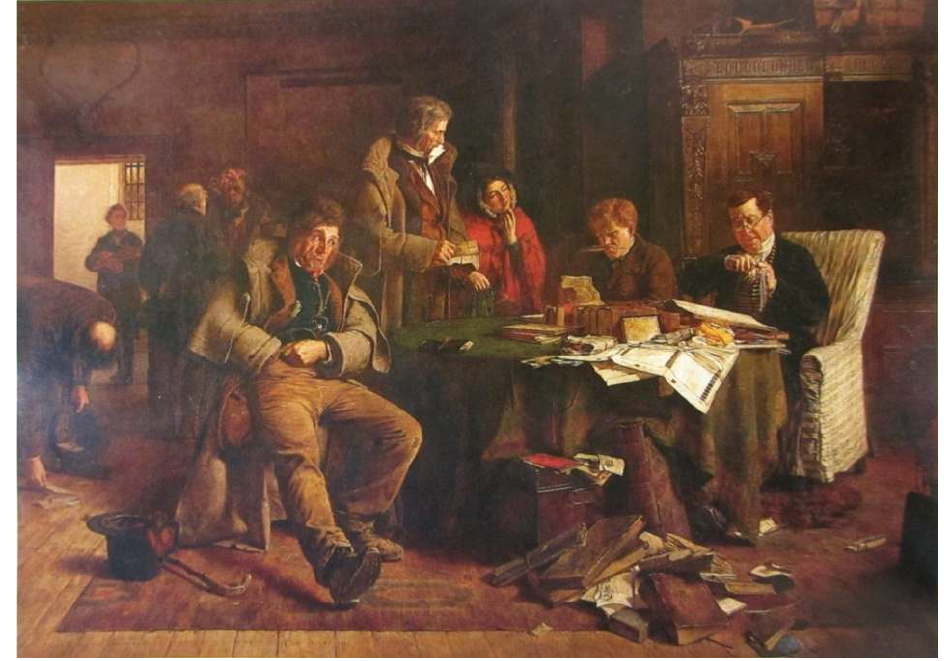
Figure 6: Erskine Nicol, Paying the Rent , oil on canvas, 122 x 166 cm, 1866, private collection, USA.